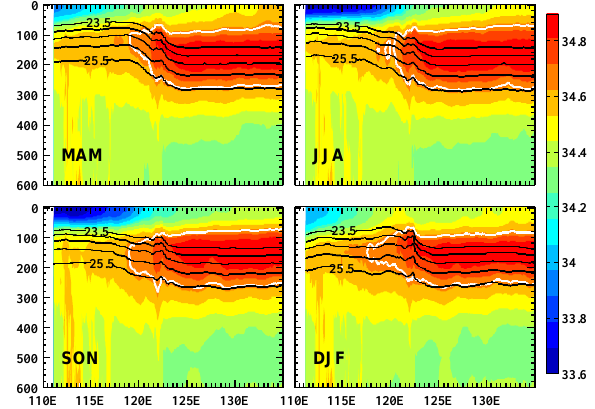
Figure 7. Salinity (color shading; PSU) and potential density (black contours; kgm − 3 ) along the flow in pink in Fig. 5. The white con- tours represent the 34.68 PSU salinity.